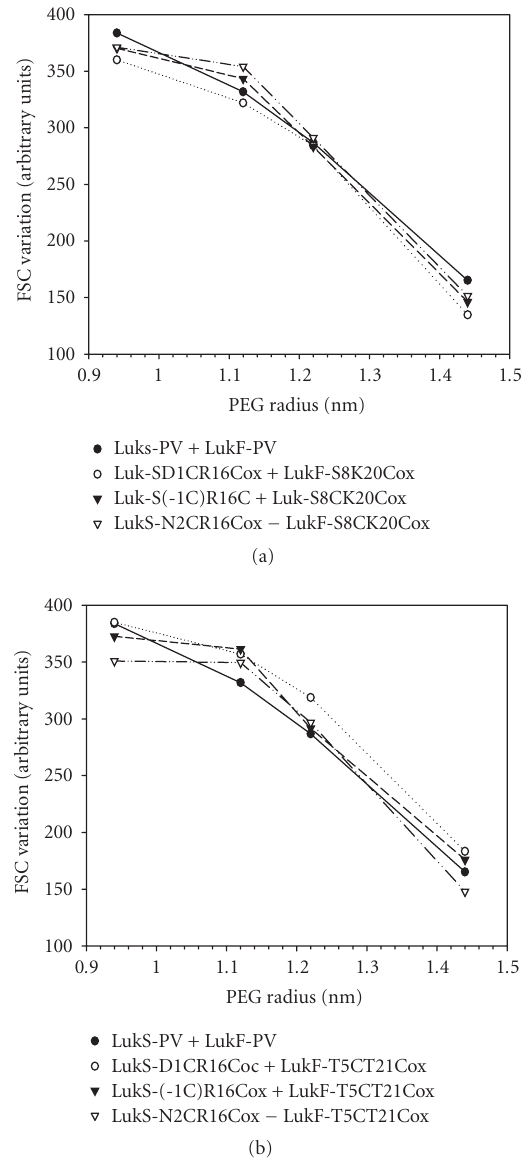
Figure 7: Determination of the hydrodynamic radius of pores formed by the di ff erent combinations of oxidized LukS-PV (20 nM) and LukF-PV (100nM) mutants 30 minutes after application of tox- ins to human PMNs. Osmotic protection was assessed by variations of the mean FSC (forward light scatter) value in the presence of polyethylene glycol molecules of di ff erent hydrodynamic radii. (a) Oxidized LukS-PV double mutants were tested with LukF-PV S8C- K20Cox. (b) Oxidized LukS-PV double mutants were tested with LukF-PV T5C-T21Cox.